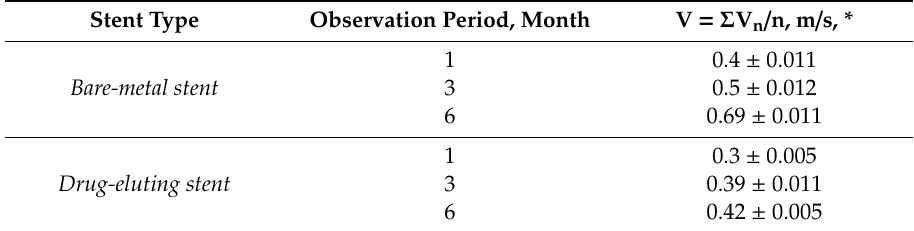
Table1. Linearbloodflowvelocityintheregionofimplantedstentatdi ff erenttimepointsofobservation.